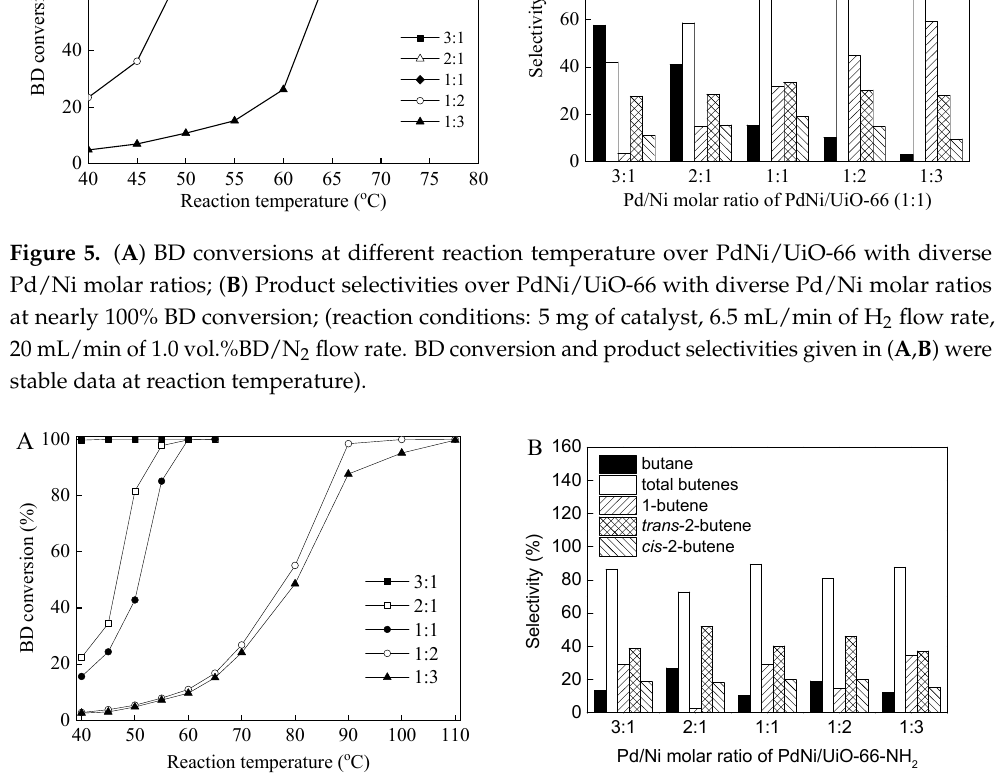
Figure 6. ( A ) BD conversions at different reaction temperature over PdNi/UiO-66-NH 2 with diverse Pd/Ni molar ratios; ( B ) Product selectivities over PdNi/UiO-66-NH 2 with diverse Pd/Ni molar ratios at nearly 100% BD conversion; (reaction conditions: 5 mg of catalyst, 6.5 mL/min of H 2 flow rate, 20 mL/min of 1.0 vol.%BD/N 2 flow rate. BD conversion and product selectivities given in ( A , B ) were stable data at reaction temperature).